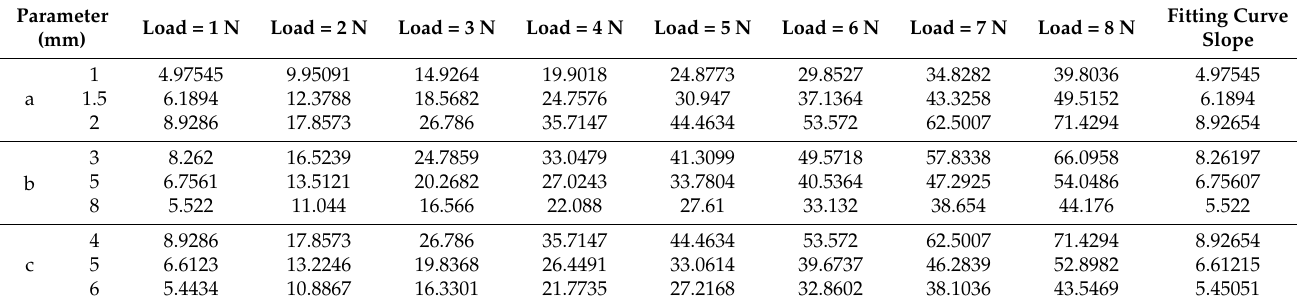
Table 2. The data of parameters a, b and c under different